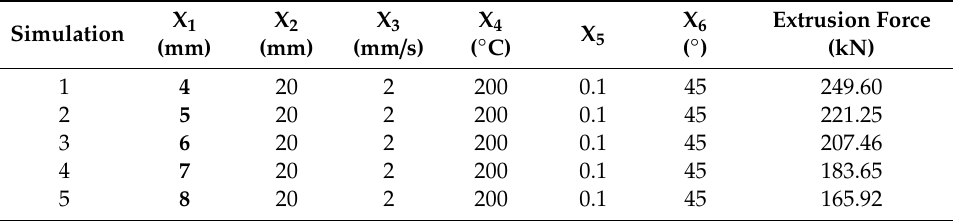
Table 6. Variables combination by varying X 1 (core diameter).